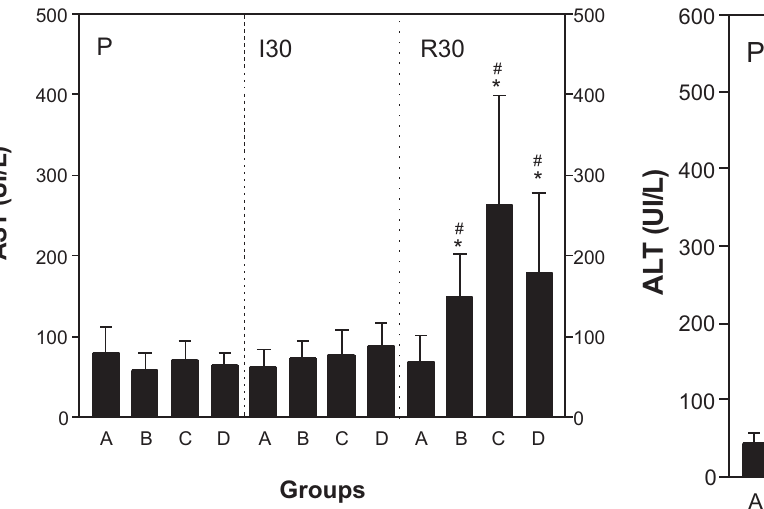
FIGURE 1 – Serum aspartate transferase (AST) level in animals dur- ing the surgical procedure